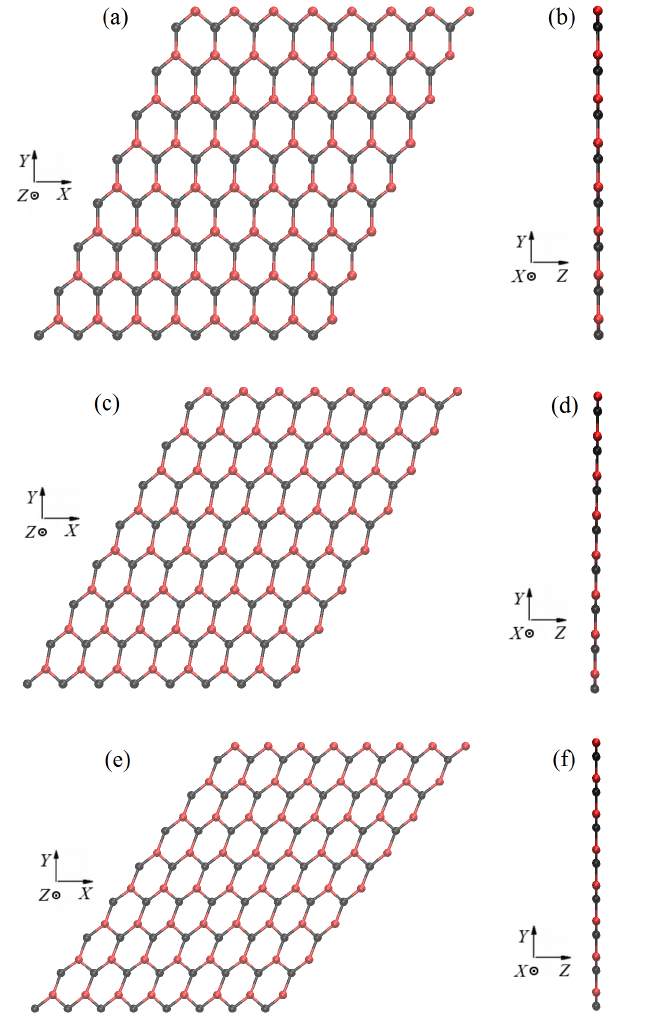
Figure 9. The structure of stanene at point B shown in Figure 7b for the three values of shear strain: ( a , b ) for ε xy = 0; ( c , d ) for ε xy = 0.15, and ( e , f ) for ε xy = 0.3. Other components of strain are ε xx = 0.0, ε yy =